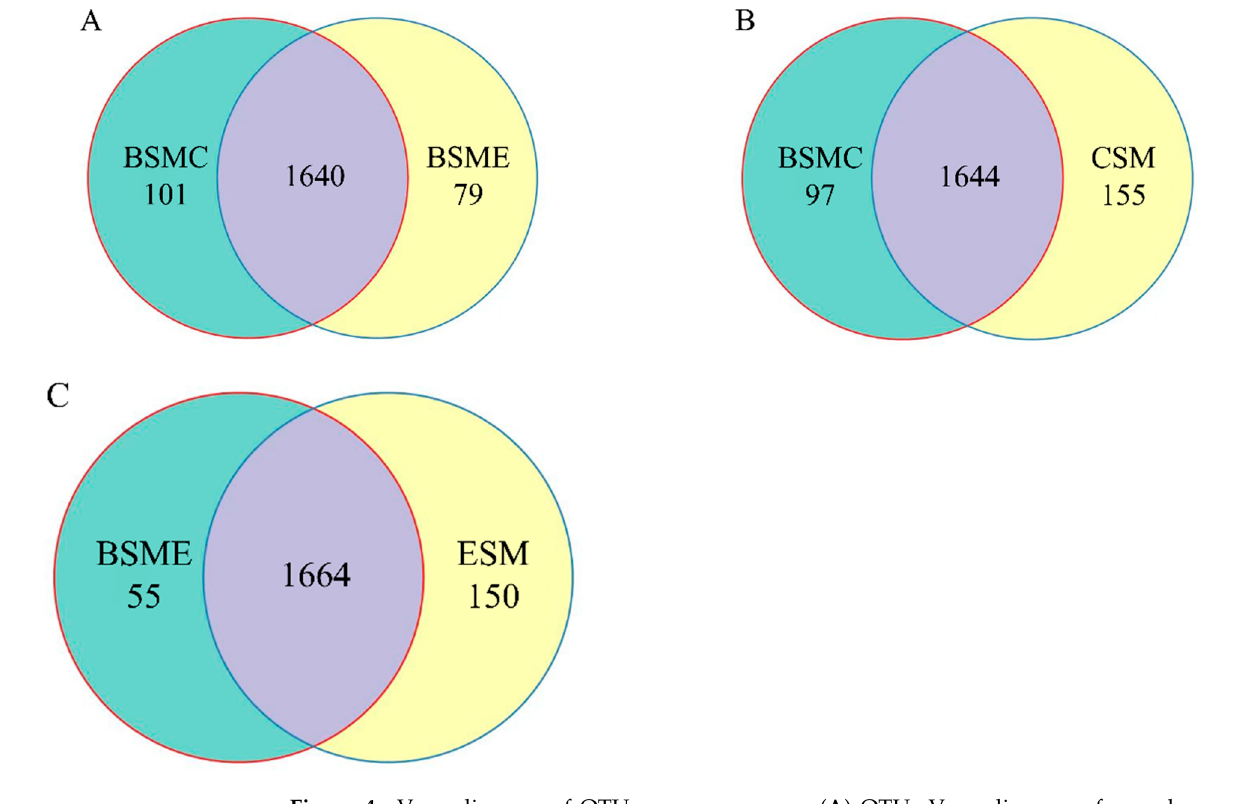
Table 5. Alpha diversity of soil samples.